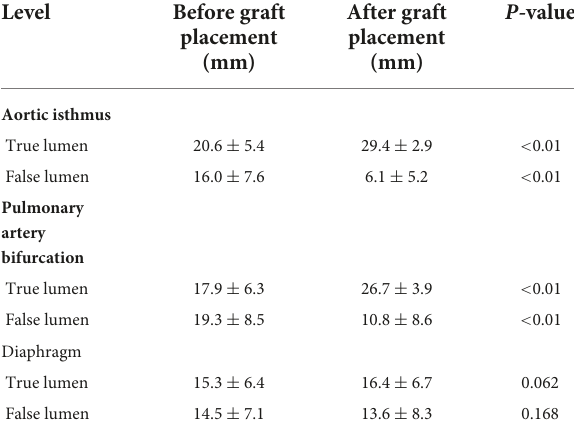
TABLE 4 Changes in aortic diameter in 42 patients with aortic